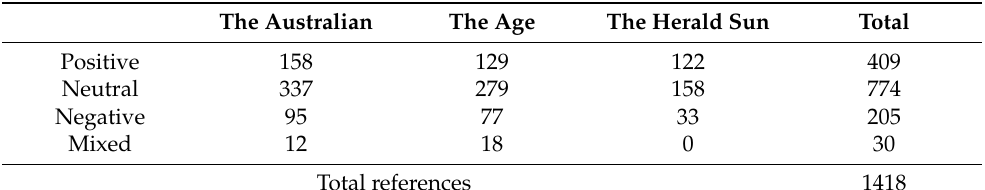
Table 3. Tone of references coded across the newspapers.